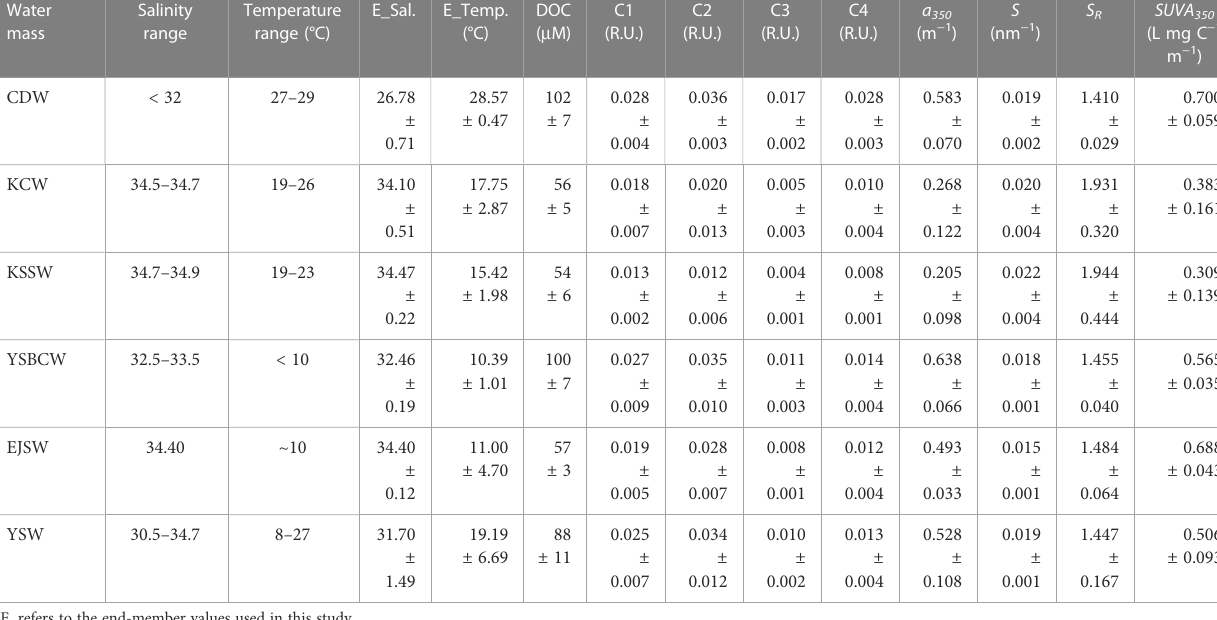
TABLE 1 Source water types and their speci fi c hydrological (salinity and temperature) and DOM properties (DOC, FDOM components, and CDOM parameters) considered in the OMP analysis. Water Salinity mass range